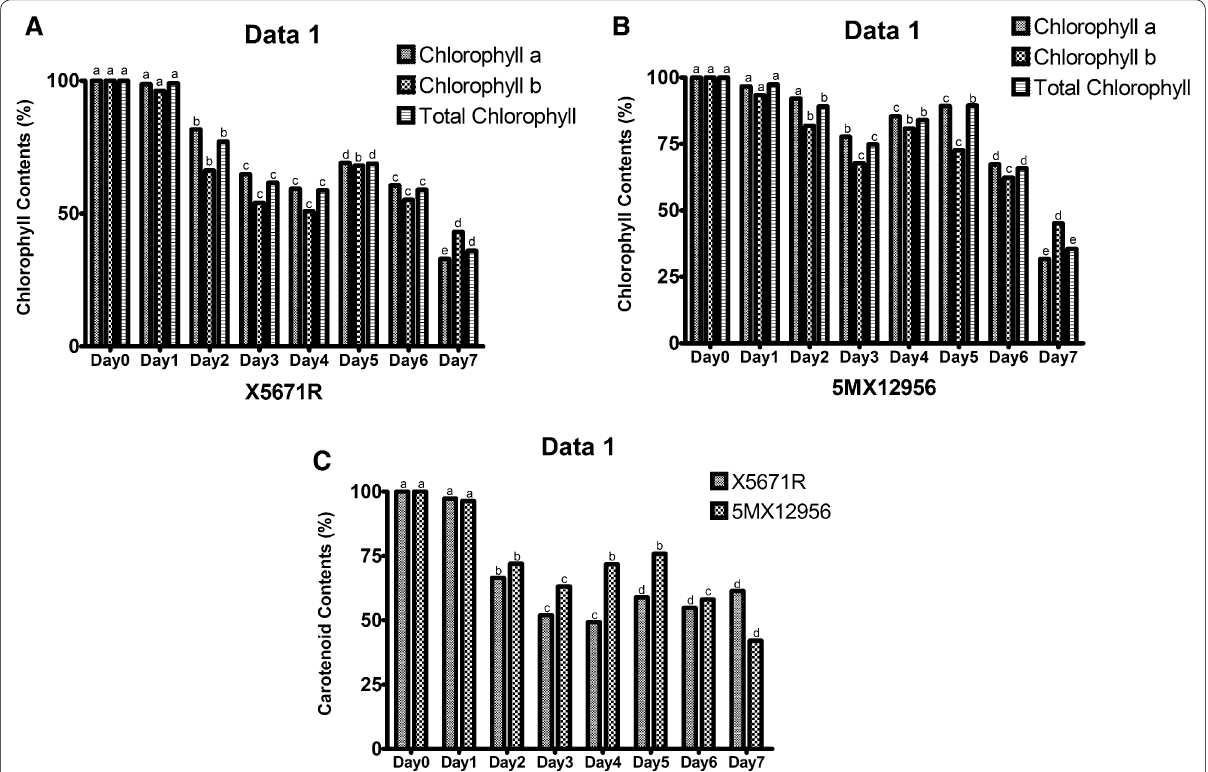
Fig. 2 Effects of 7 days-long drought stress on photosynthetic pigment concentrations of X5671R ( A ) and 5MX12956 ( B ) and carotenoid ( C ). In all results, Day 0 is estimated as 100% and calculations presented as percentage changes comparing to the Day